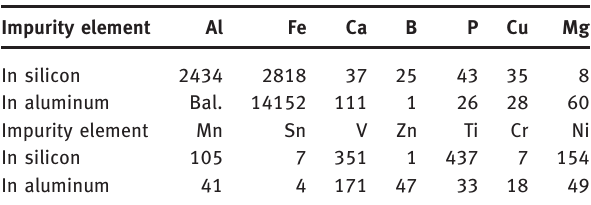
Table 1: Impurity content in raw materials (ppmw).